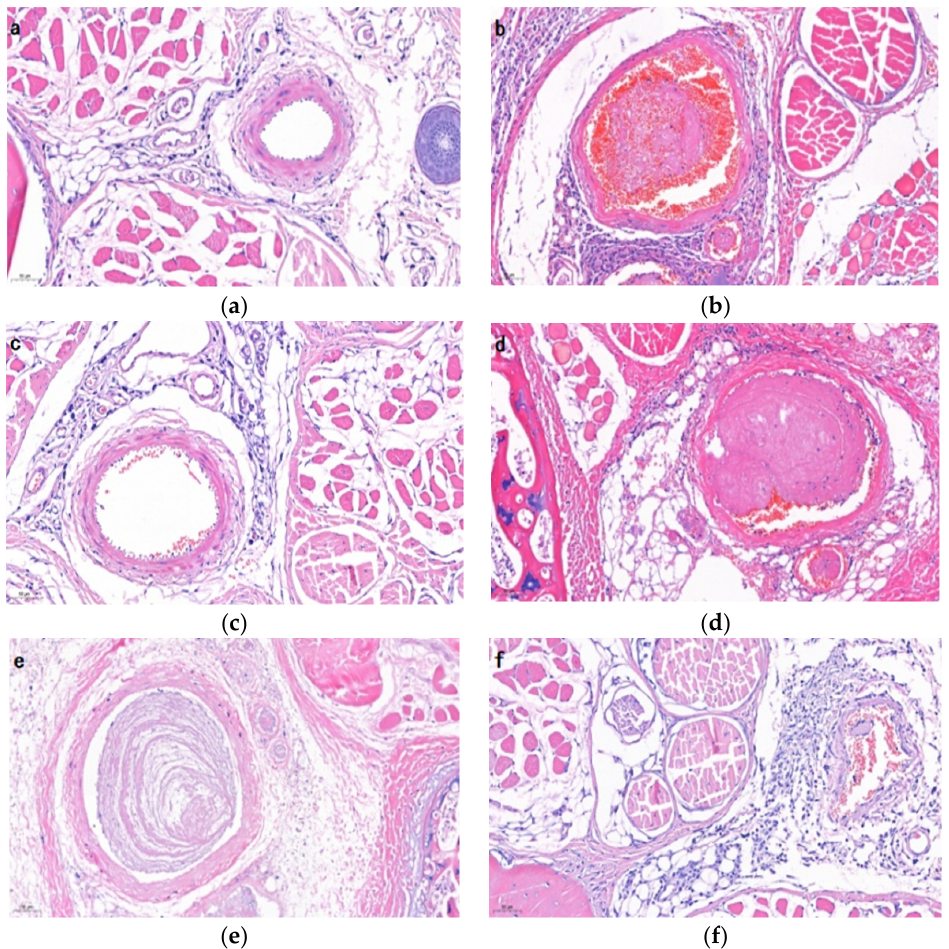
Figure 7. Effects of AAP-b2 on the histomorphology of tail tissues in thrombosis model mice. ( a ) Control group, ( b ) model group, ( c ) aspirin group, ( d ) Test-L group, ( e ) Test-M group, ( f ) Test-H group.